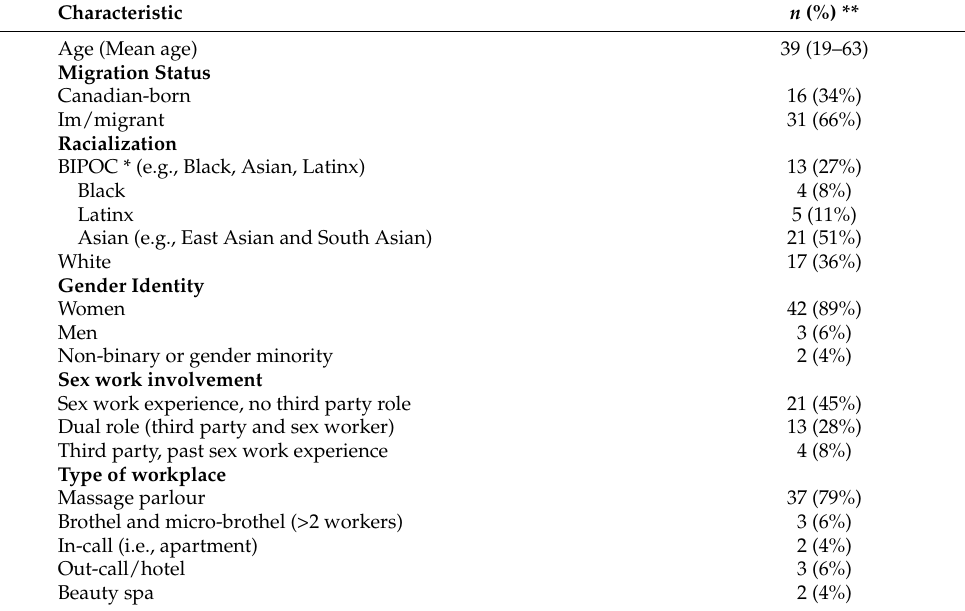
Table 1. Individual and structural characteristics of indoor sex workers and third parties in Metro Vancouver, Canada ( n = 47), AESHA